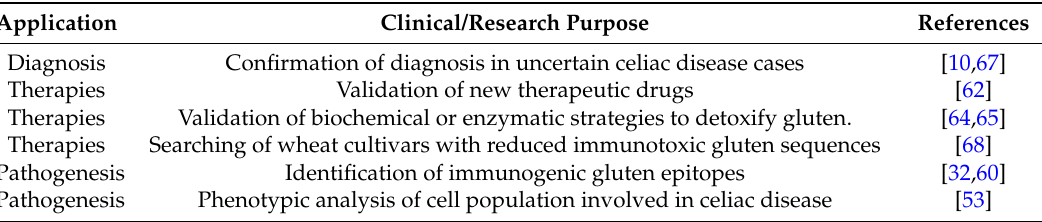
Figure 1. Percentage of subject responders to the short gluten challenge. A cohort of 36 Italian DQ2-positive young celiac patients [8,60] consumed 3–4 wheat bread slices (corresponding to 9–12 g of gluten/die) for three days. Immunoreactivity was evaluated in peripheral blood at day 0 and day 6 by INF- γ -ELISPOT assay, in response to either whole gliadin or immunodominant α -gliadin peptides. Table 1. Possible translational applications of brief gluten challenge.